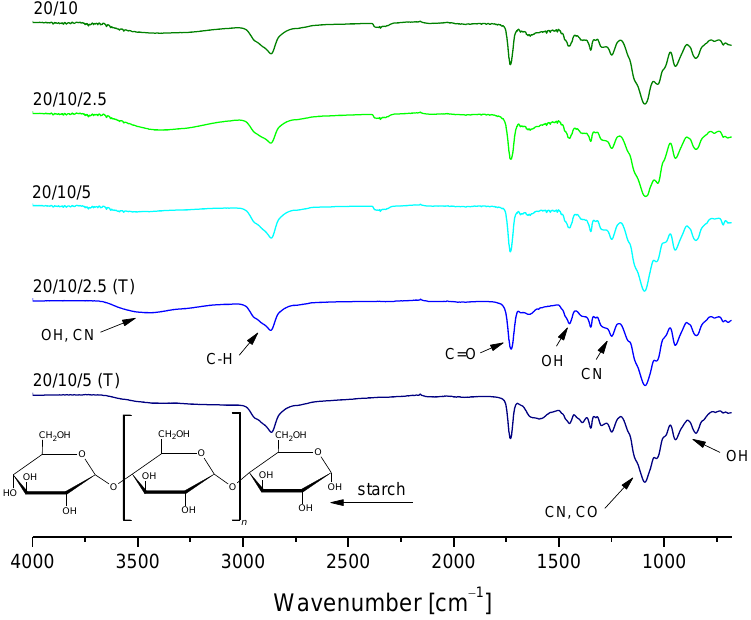
Figure 9. FT-IR spectra of hydrogels with starch compared to the unmodified materials. Based on the FT-IR spectra of starch-modified hydrogel materials before and after modification it was observed that the material did not significantly change its chemical structure. On the spectra of modified polymers any new bands which could derive from the additive (starch) were not observed. On the other hand, a dependance between the intensity of bands from hydrogels with starch solution (“cold starch”) and starch suspension (“hot starch”) was observed. Bands deriving from samples modified with 2.5 mL of starch solution (“hot starch”) showed higher intensity than bands observed on the FT -IR spectra of samples containing starch soluti on prepared at room temperature (“cold starch”). The same conclusion may be drawn analyzing the bands deriving from samples modified with 5 mL of starch solutions. This may be caused by the fact that in the case of